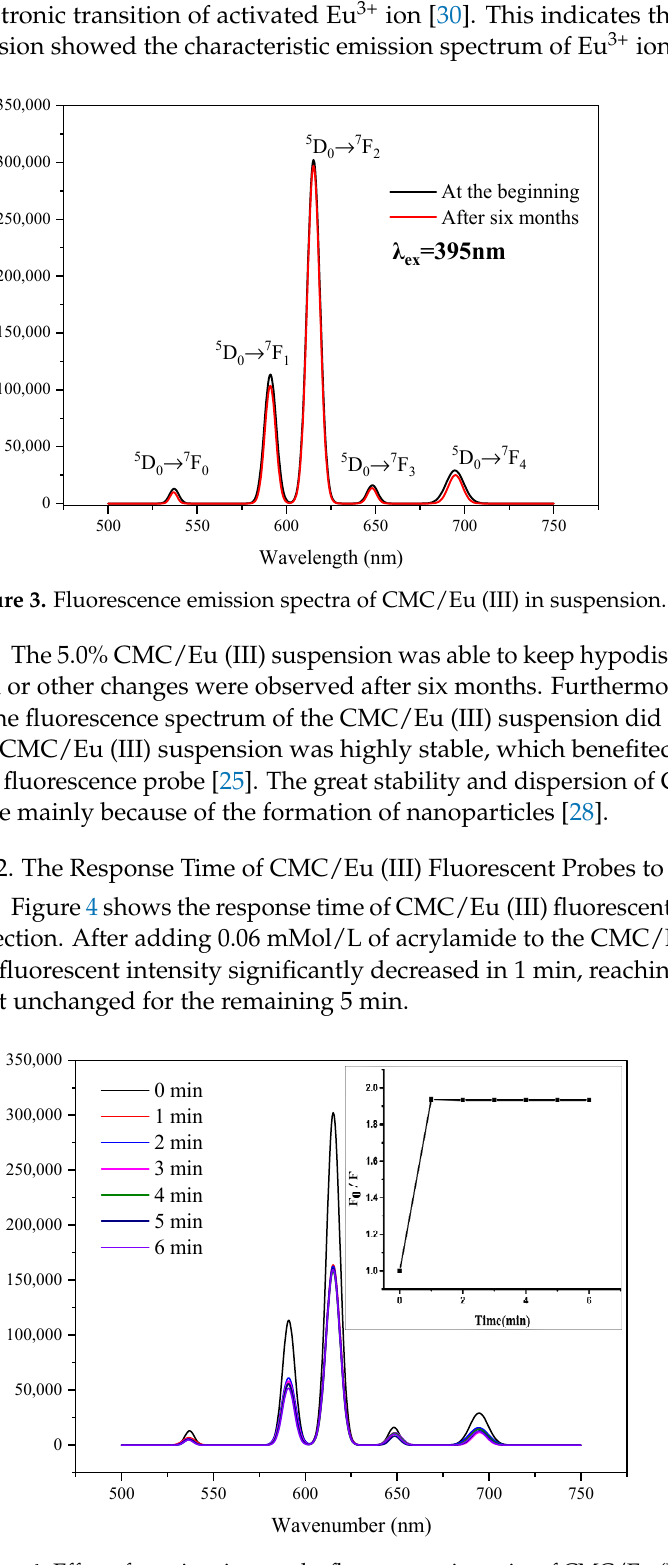
Figure 4. Effect of reaction time on the fluorescence intensity of CMC/Eu ( Ⅲ ) probe at 544 nm (F 0 , CMC/Eu (III) fluorescent probe; F, CMC/Eu (III) fluorescent probe within 0.06 mMol/L